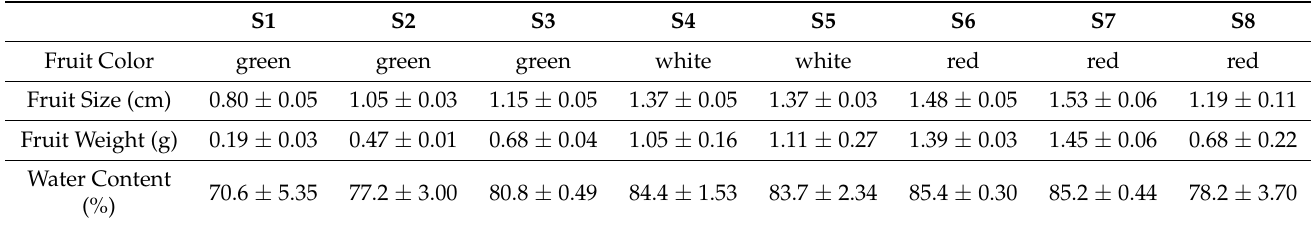
Table 2. Fruit diameter, weight, and water content at each ripening